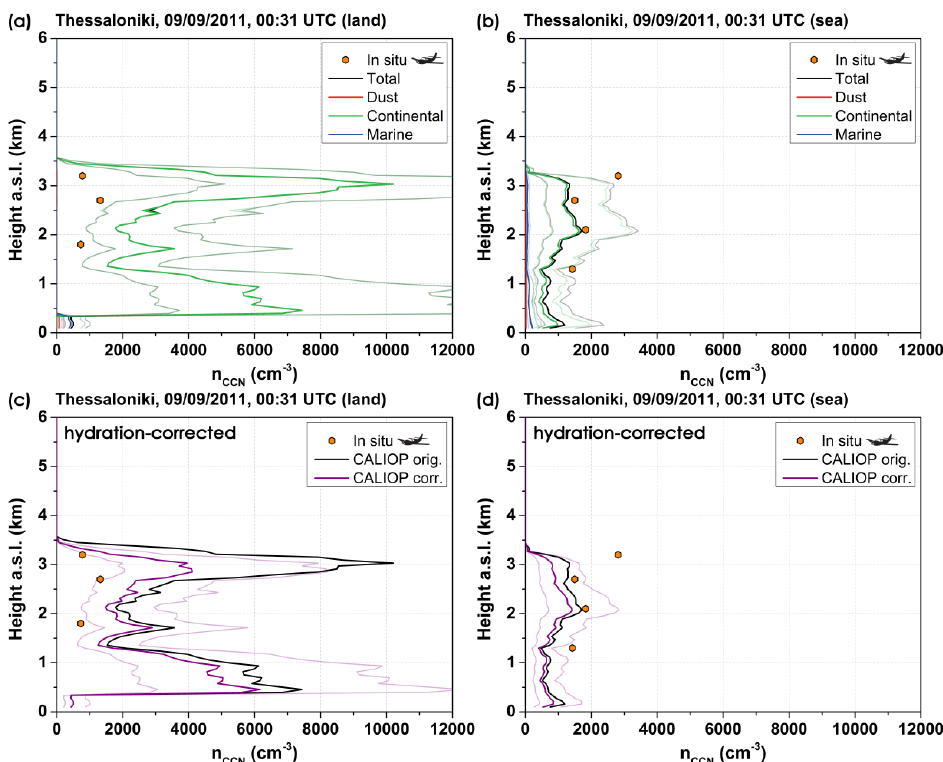
Figure 9. Profiles of CALIPSO-derived CCN concentrations for all the aerosol types together (total), for dust, continental, and marine aerosols at a supersaturation of 0.15% for the land (40.6°–41.2° N) (a)* and sea (40°–40.6° N) (b) areas around Thessaloniki during the Aerosol Classification scheme over Eastern Mediterranean (ACEMED) Facility for Airborne Atmospheric Measurements ( FAAM) BAe-146 flight. Transparent color lines indicate an uncertainty of a factor of two. Dry particle number concentrations retrieved with the In situ/Remote sensing aerosol Retrieval Algorithm (IRRA) algorithm using in situ and lidar remote sensing data from the ACEMED flight are shown as circles. Profiles of the original and the hydration-corrected Cloud-Aerosol Lidar with Orthogonal Polarization (CALIOP)-derived total CCN concentrations are plotted separately for the land (c) and sea (d) areas around Thessaloniki. *Continental CCNs dominate and hence their profile (green color) overlaps with the total CCN profile (black line). Table 1. Original and hydration-corrected CALIPSO-derived CCN concentrations (in cm −3 ) and dry particle number concentrations (in cm −3 ), retrieved with the IRRA algorithm using ACEMED flight measurements at different height levels over Thessaloniki, Greece. The factor of two uncertainty range is given in parentheses. Columnar CCN concentrations (including particles with radius larger